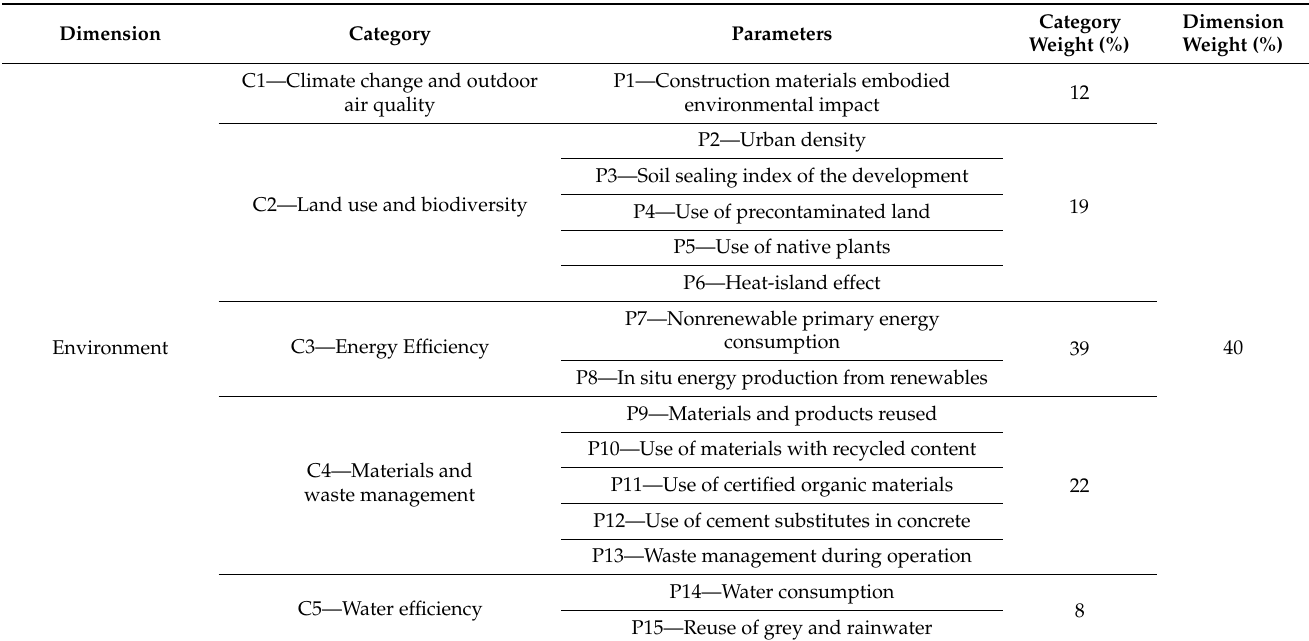
Table A1. SBTool PT -H list of categories and